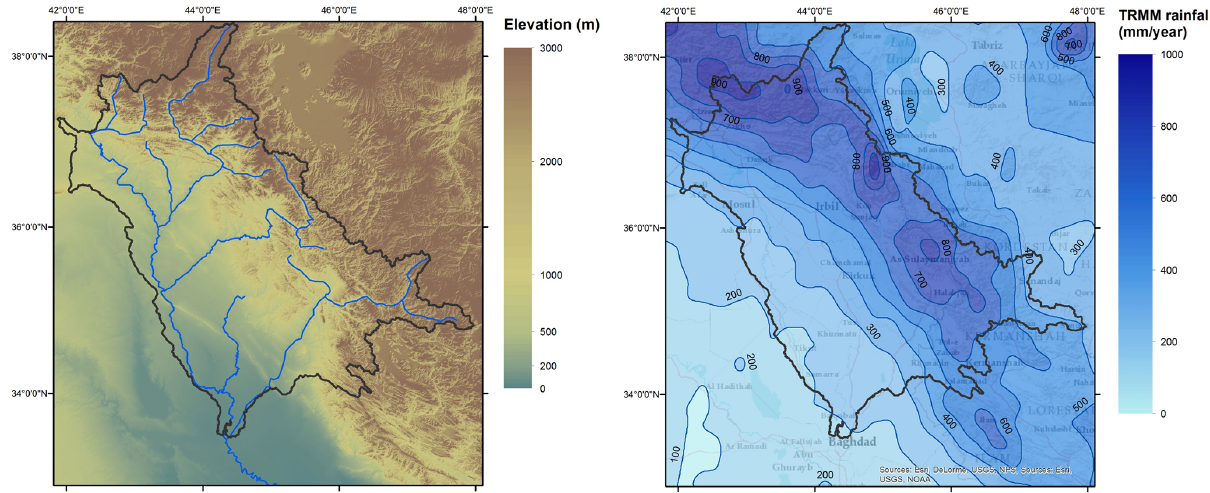
Figure 1. (left) Topographic map of northern Iraq based on SRTM data and (right) the average yearly rainfall between 2002 and 2012 (mmyr − 1 ) based on TRMM